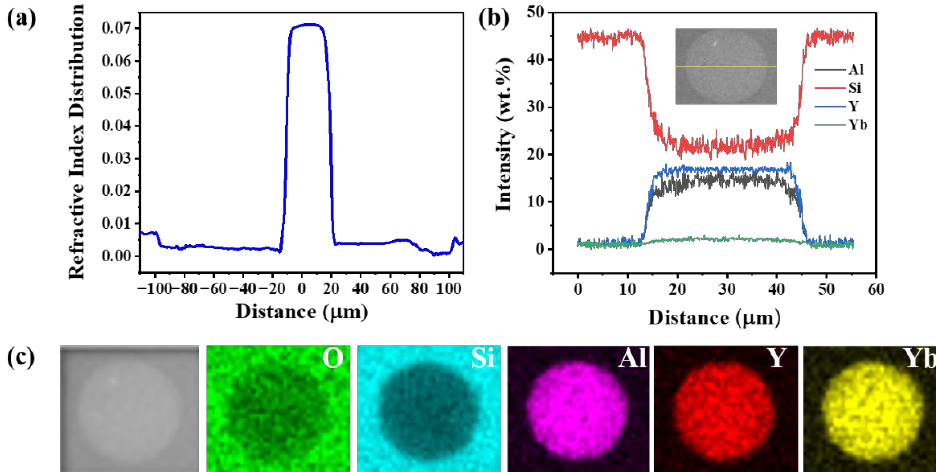
Figure 1. ( a ) Refractive index distribution of the YCDSF cross-section. ( b ) Elemental distribution curve along the diameter of the YCDSF. ( c ) Two-dimensional elemental distribution of the YCDSF in cross-section. Table 1. Elemental concentrations of YCDSF.